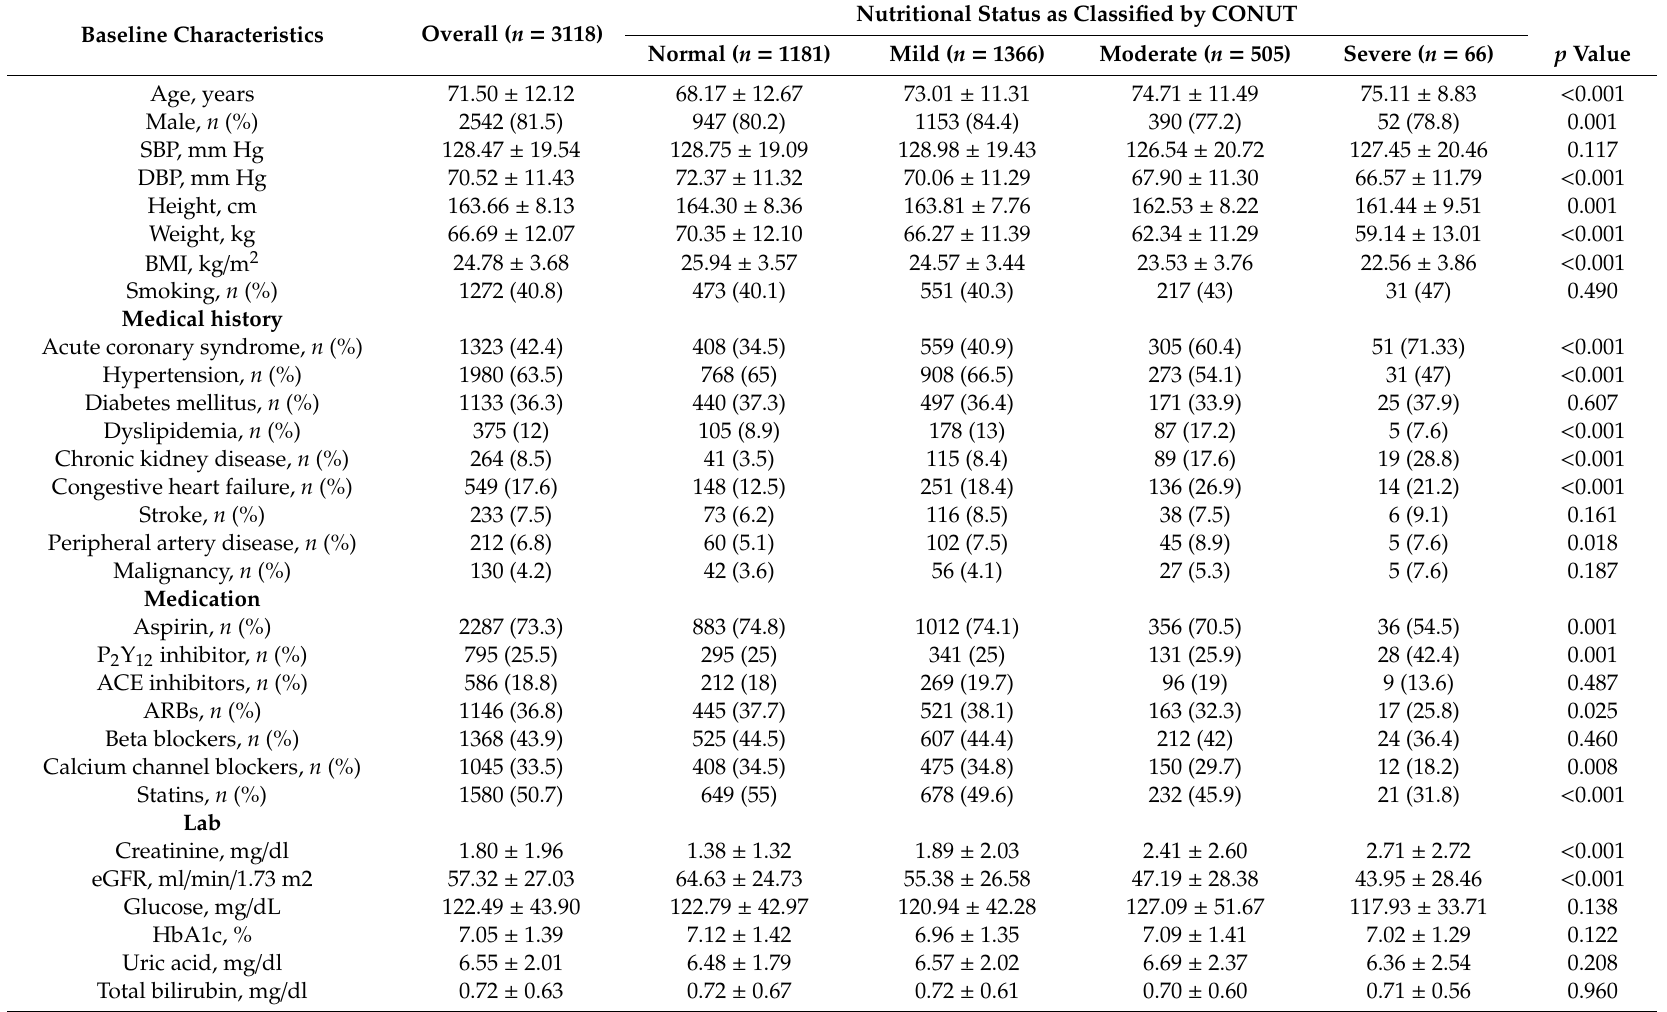
Table 1. Baseline characteristics of patients in di ff erent categorical groups of nutritional